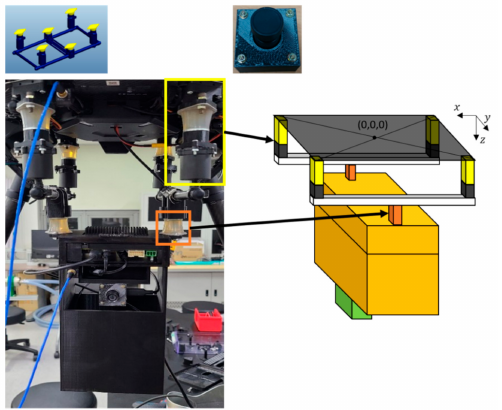
Figure 5. Configuration of selected mounts for the gimbal system.